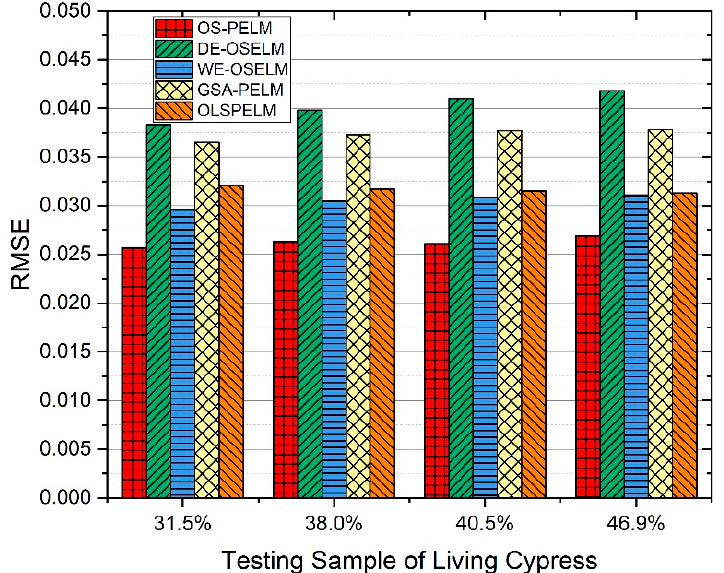
Figure 16. For four samples of cypress trees with different moisture contents (31.5%, 38.0%, 40.5%, and 46.9%), the prediction accuracy of the five methods was evaluated. and 46.9%), the prediction accuracy of the five methods was